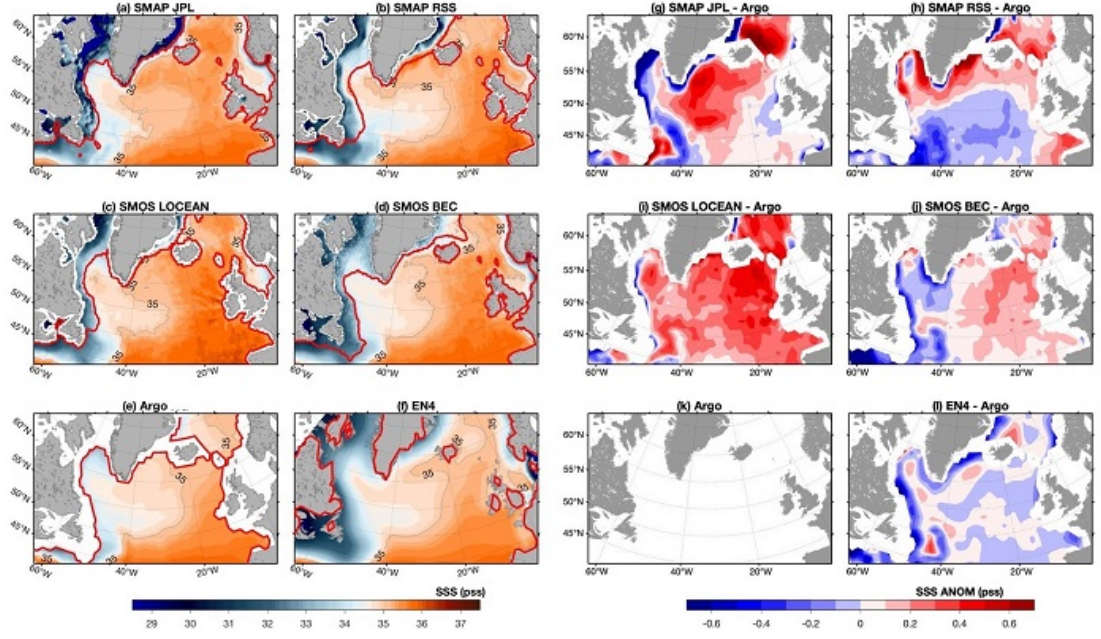
Figure 3. ( a ) ‐ ( f ) Time ‐ mean SSS patterns averaged over the three full years 2016–2018. ( g ) ‐ ( l ) The difference anomaly fields referenced to the Argo mean SSS, (a) and (g) for SMAP JPL, ( b ) and ( h ) for SMAP RSS, ( c ) and ( i ) for SMOS LECEAN, ( d ) and ( j ) for SMOS BEC, ( e ) and ( k ) for Argo, and ( f ) and ( l ) for